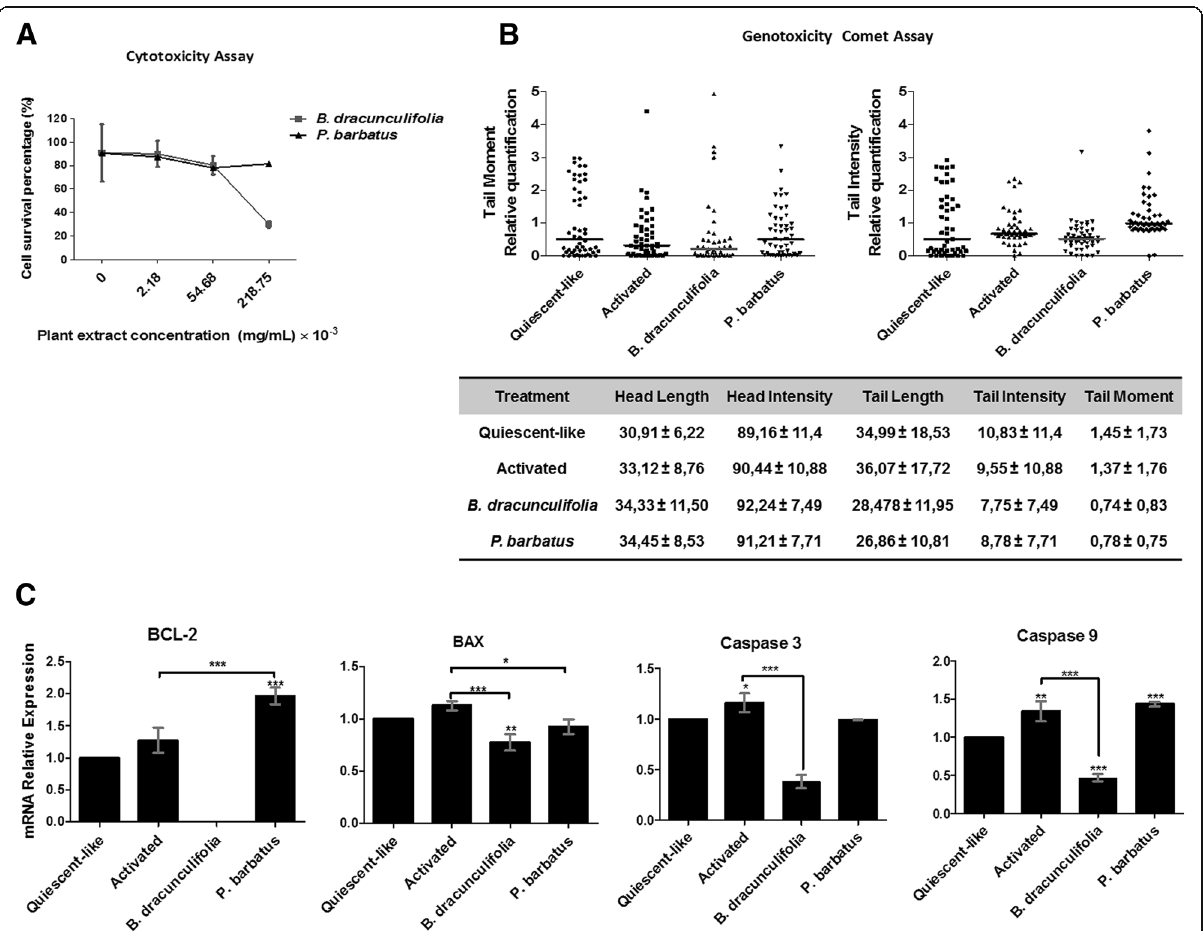
Fig. 1 Effects of the medicinal plant extracts of Baccharis dracunculifolia and Plectranthus barbatus in cytotoxicity, genotoxicity and relevant elements of the apoptotic process. ( a ) MTT cell viability after 24 h exposure to the extracts. ( b ) Comet assays performed after 24 h treatment with the plant extracts ( c ) Expression levels of pro-apoptotic genes were evaluated in different groups of LX-2 cells by qRT-PCR. The graphs represent the mean values ( a and c ) and medians ( b ) of at least three independent experiments ( p <